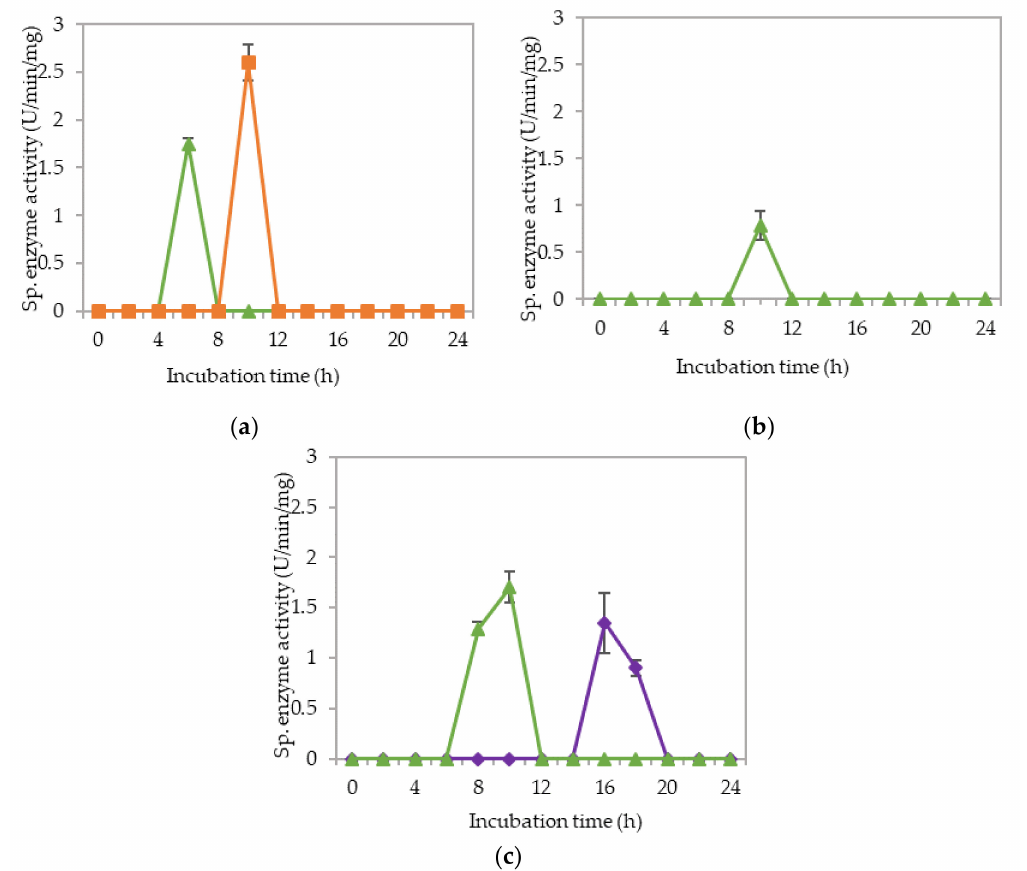
Figure 8. Specific extracellular cellulolytic and hemicellulolytic activities; ( • ) endoglucanase; ( (cid:4) ) exoglucanase; ( (cid:78) ) β -glucosidase and ( (cid:7) ) mannanase of Lactobacillus plantarum RI 11 grown in M6 (PKC and soybean pulp) for 24 h. The enzyme activities were detected at three di ff erent pH levels: ( a ) pH 5; ( b ) pH 6.5; (c ) pH 8. The error bars represent the standard deviation of specific enzyme activity of triplicate samples ( n =